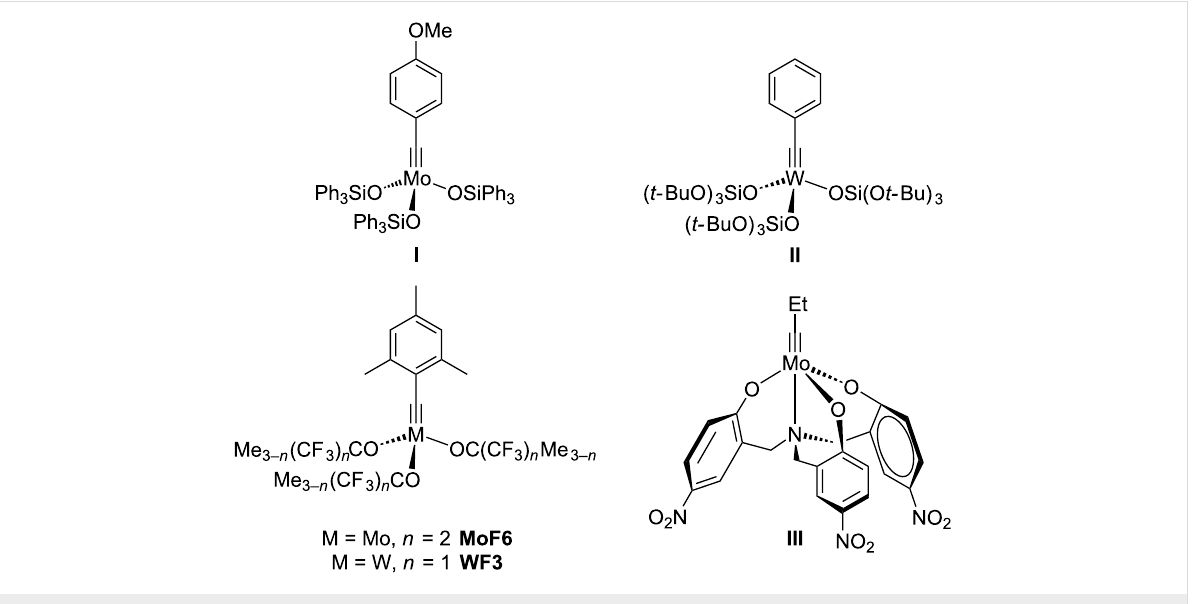
Figure 1: Well-defined catalysts for alkyne metathesis.